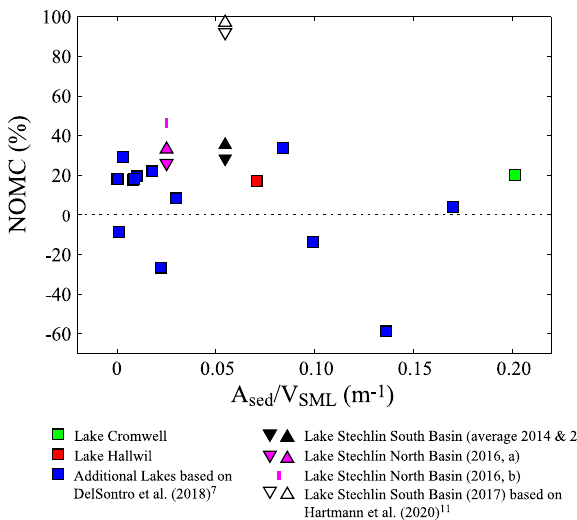
Fig. 1 The contribution of net oxic methane production to the diffusive CH 4 emission from lakes. The contribution of net oxic methane production to the diffusive CH 4 emission, NOMC, was calculated in the different lakes from the surface CH 4 fl ux, F surf , and the methane fl ux from the sediments, F sed , obtained from different data sources: Lake Hallwil (Supplementary Table 1): F surf from the “ Hallwil relationship ” that is based on the chamber measurements in Lake Hallwil 6 . F sed , from the CH 4 pore water concentrations in the sediment core collected at 3 m water depth ( F sed = Table 3): Lower and upper limits of F sed ( F sed = 1.8mmol m − 2 day − 1 and F = 2.0 mmolm − 2 day − 1 ) from the re-evaluation of the mesocosm sed experiments (Supplementary Table 2) providing upper and lower limit of NOMC, respectively (Supplementary Table 3). South Basin (average 2014, 2016): F surf from the “ Stechlin relationship ” ; North Basin (2016, a): F surf from chamber measurements; North Basin (2016, b) F surf from chamber measurements combined with the “ Stechlin relationship ” for the 20 June; Lake Stechlin South Basin (2017) (Supplementary Table 4): F sed derived from CH 4 pore water measured in a single sediment core by ref. 11 , considering the CH 4 gradient in the top 2cm and at 5cm depth ( F sed = and lower limit of NOMC, respectively; F surf from speci fi c wind model of ref. 11 ; Lake Cromwell: Data from ref. 5 . Additional Lakes (Supplementary Table 5): based on the analysis of ref. 7 (see Supplementary Note 4). The ratio between the area of the sediment A sed and the volume V SML in the surface mixed layer SML, A sed /V SML , was estimated assuming a slope angle of 5° for the lake bed (Supplementary Note 4). The sensitivity to the slope angle is illustrated in Supplementary Fig. 5 assuming a slope angle of 3°.